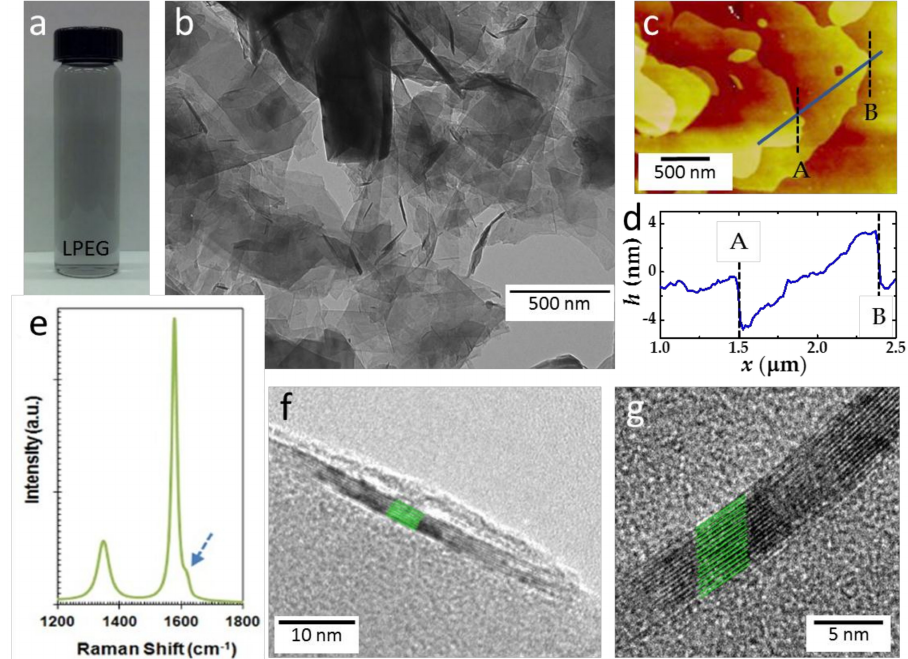
Figure 1. Optical characterization of the prepared liquid-phase exfoliated graphene (LPEG)